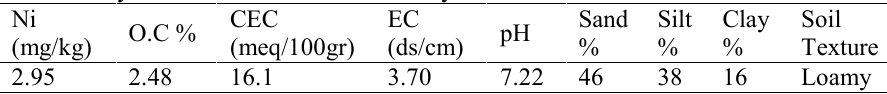
Table 1. Physiochemical Features of Primary